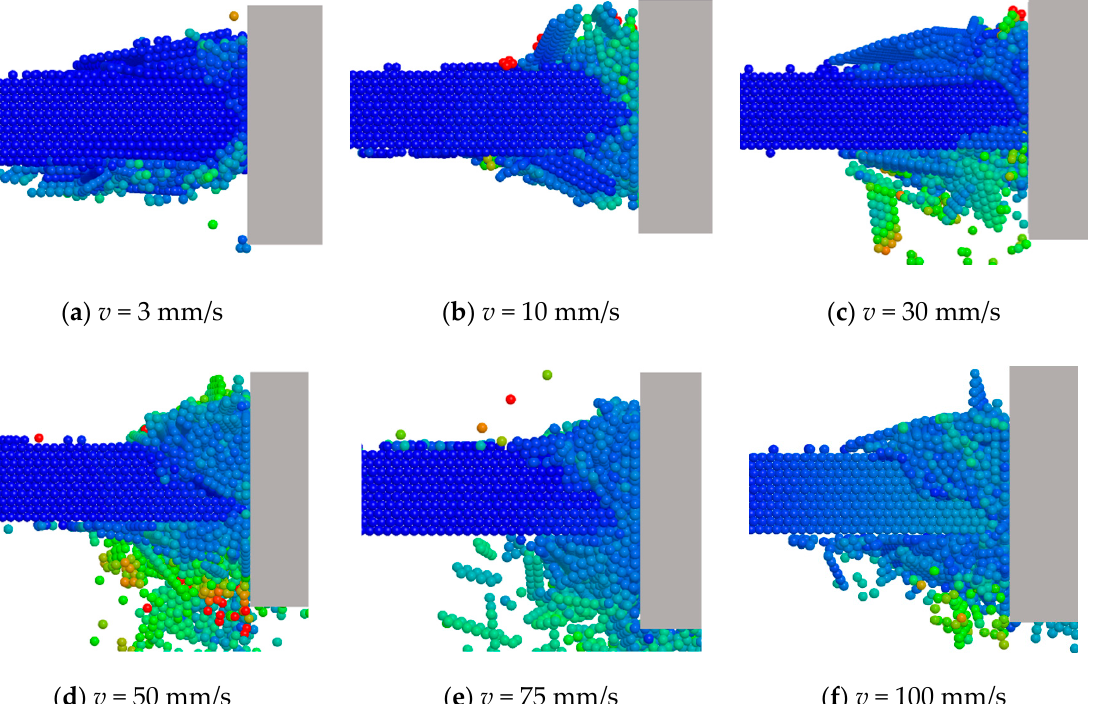
0 Figure 14. Influence of the loading rate on high-pressure zones. 4. Conclusions In this study, the interaction between sea ice and vertical structures was simulated with a spherical DEM model considering inter-particle bonding and breaking. A compar- ison with a field test was provided to validate the rationality of this numerical model. Both the ice load and local ice pressure distribution characteristics from the DEM results were in agreement with the experimental data. Moreover, a line-like distribution of high-pres- sure zones was also obtained in this simulation. Through the discrete element analysis, it can be seen that the generation and distribution of the high-pressure zones is closely re- lated to the failure mode of sea ice. Two factors influencing the local pressures were in- vestigated, including the contact area and load speed. The local pressure decreases with increasing area, which is consistent with the relationship in the ISO standard. On the other hand, the load rate has a positive influence on the local ice pressure, which could lead to a change in the failure modes.